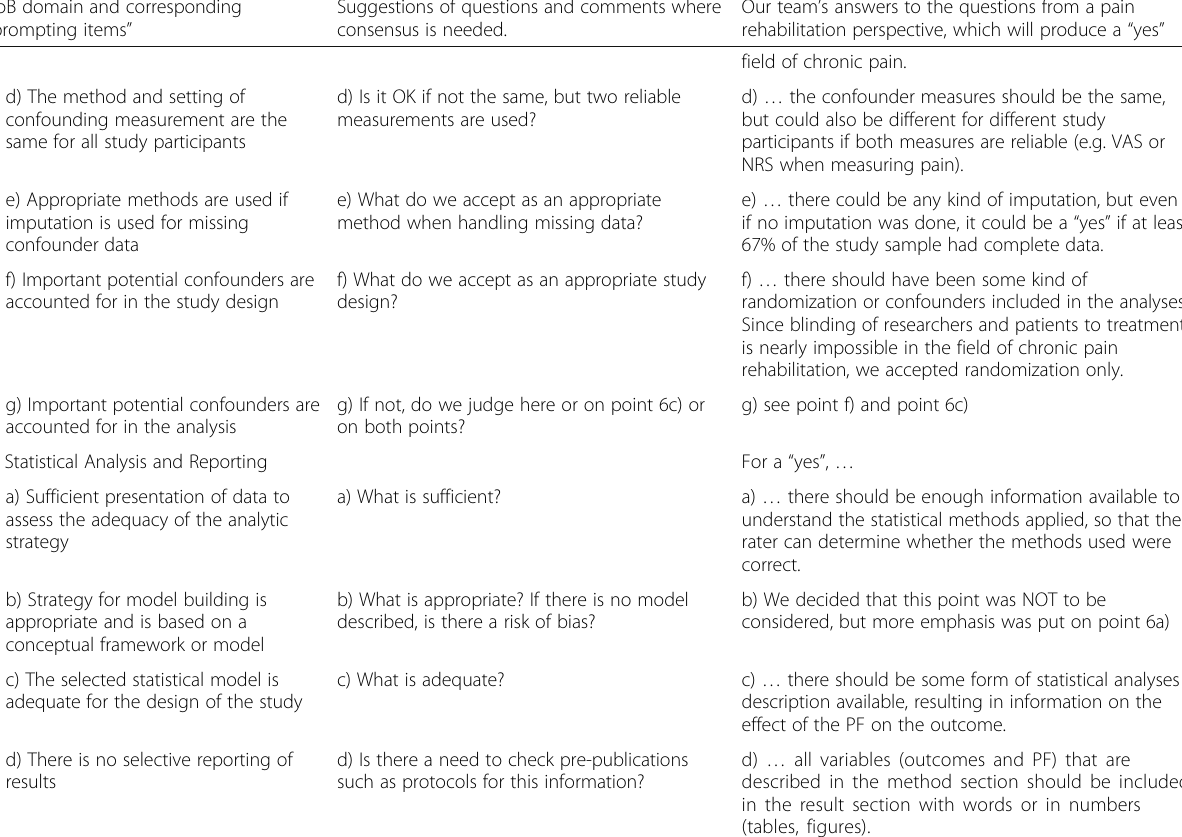
Table 3 Suggestions for questions and comments on QUIPS risk of bias domains and our team ’ s proposed answers (Continued) RoB domain and corresponding Suggestions of questions and comments where Our team ’ s answers to the questions from a pain “ prompting items ” consensus is needed. rehabilitation perspective, which will produce a “ yes